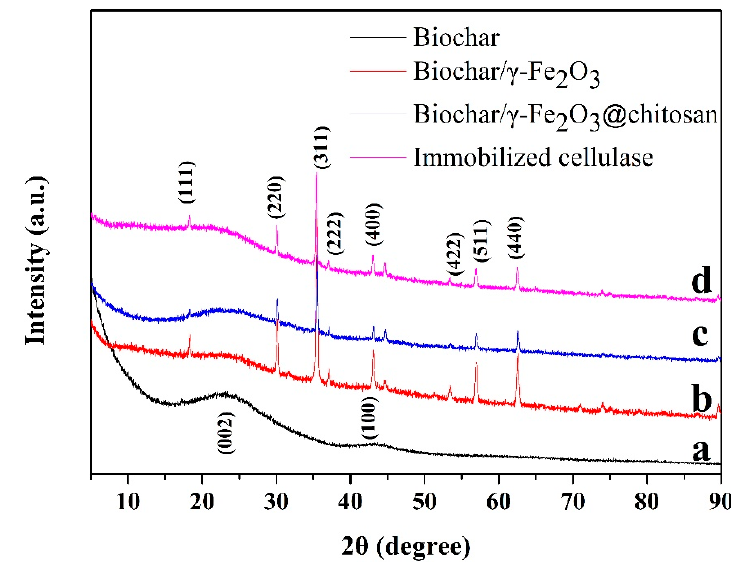
Figure 1. The X-ray diffraction (XRD) patterns of biochar ( a , black curve), biochar/ γ -Fe 2 O 3 ( b , red curve), biochar/ γ -Fe 2 O 3 @chitosan ( c , blue curve), and immobilized cellulase ( d , pink curve).